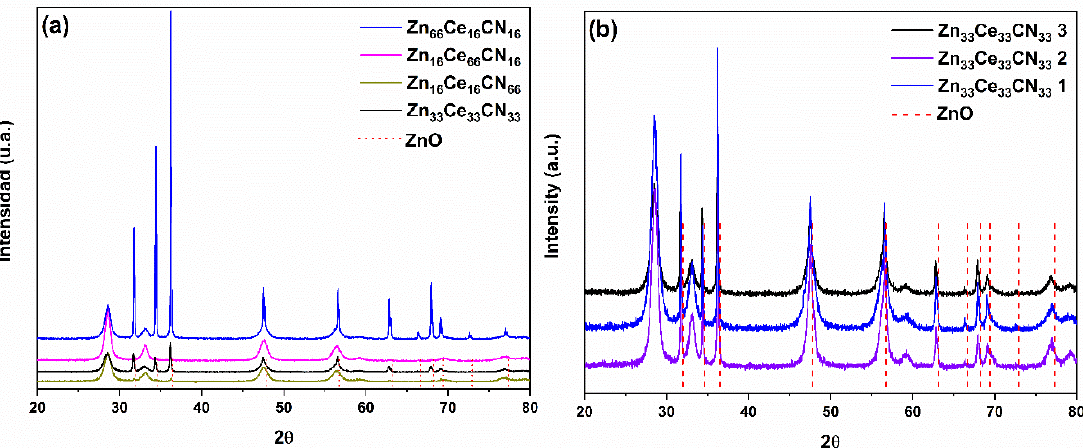
Figure 4. Diffraction patterns of ( a ) ternary mixtures and of the ( b ) replicate samples.